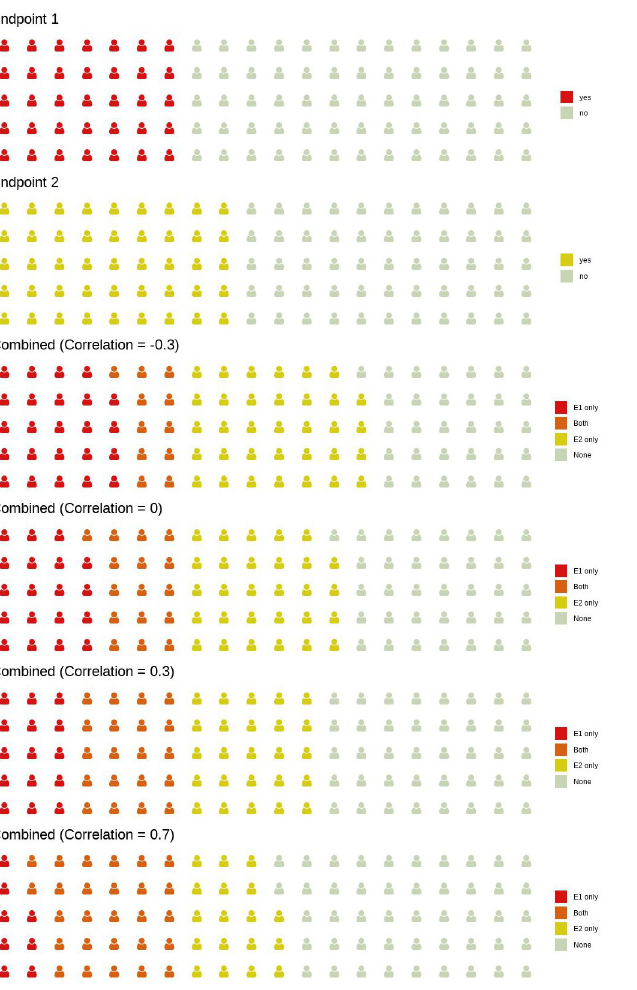
Fig 3. Impact of different levels of correlation between endpoints 1 and 2 on the expected number of responders. Assuming a response rate of 30% for endpoint 1 and 40% for endpoint 2, we expect 30/100 patients to reach endpoint 1 (in red) and 40/100 patients to reach endpoint 2 (in yellow), regardless of the correlation. Depending on different levels of the correlation, the number of responders that reach both endpoints simultaneously (in orange) varies; it increases with increasing correlation. In contrast, the expected number of trial participants that reach at least on of the two endpoints decreases with increasing correlation (in this example, this number is 69 when the correlation is -0.3 and 53 when the correlation is